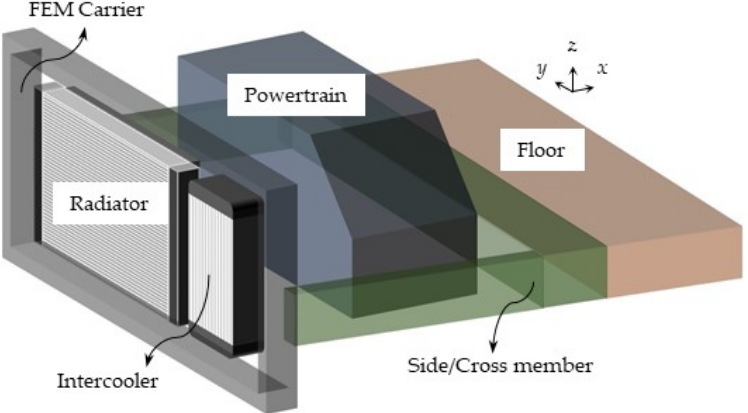
Figure 1. Components of a diesel SUV on the transmission paths of idling vibration.